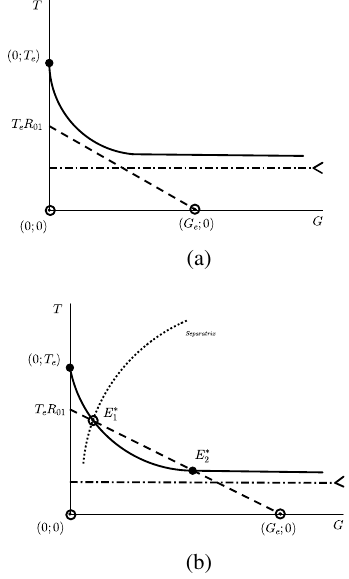
Fig. 2: Equilibria and their stability/instability properties when R 01 < 1 and ω ( G e ) R 10 > 1 . In (a), there is no coexistence and only wooded savanna equilibrium is GAS as in Table I and Table II.